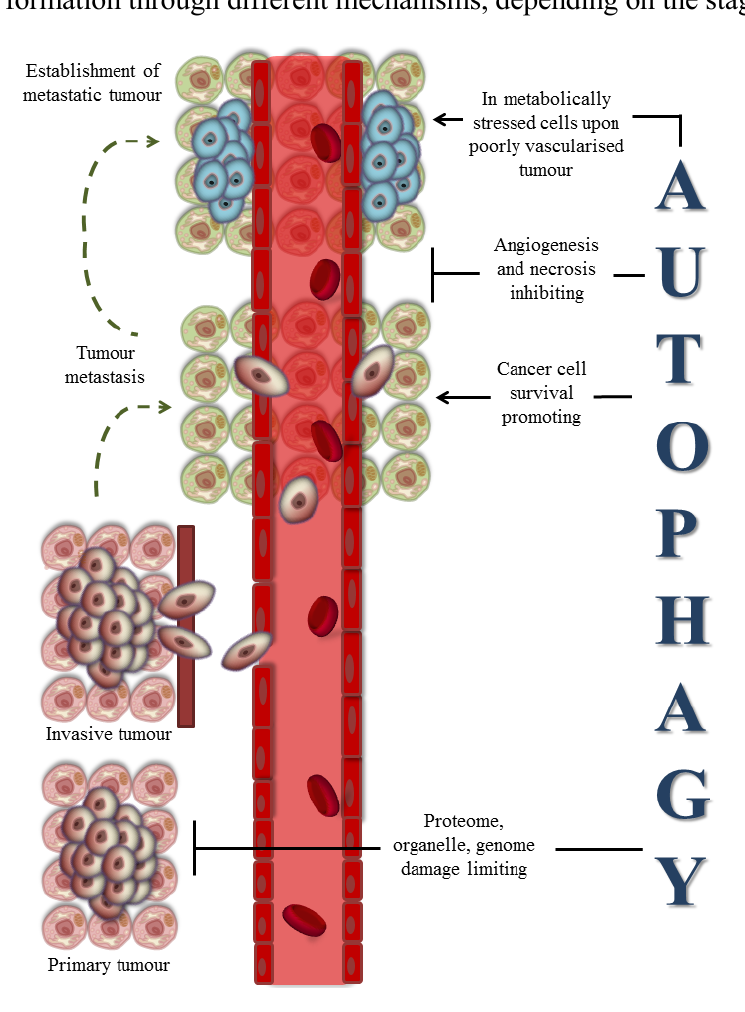
Figure 2. Multiple roles of autophagy during tumorigenesis. Autophagy can both inhibit and promote cancer formation through different mechanisms, depending on the stage of